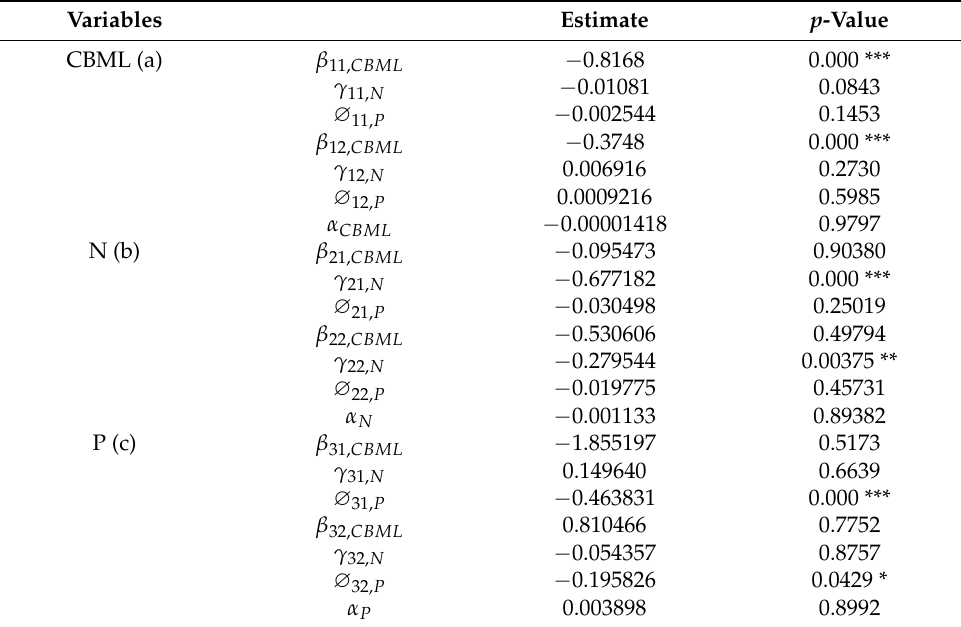
Table 3. Estimation of VAR coefficients and significance test values, CBML